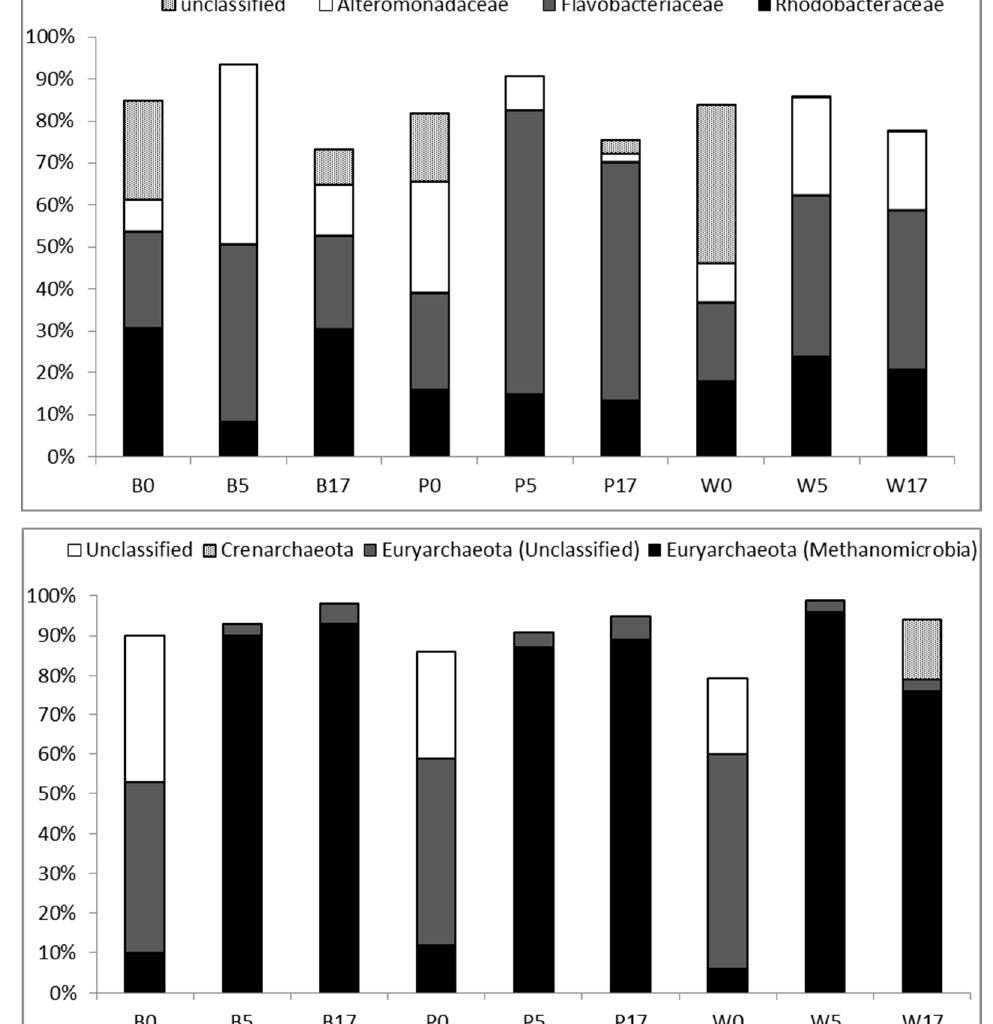
Figure 5. Relative abundance of dominant Bacterial families (cumulative 70%) and Archaeal phyla (cumulative 80%) in the three different sites at day 0, day 5-exponential growth, day 17-stationary phase. B: Banyuls, P: Pagasitikos, W: Woods Hole.